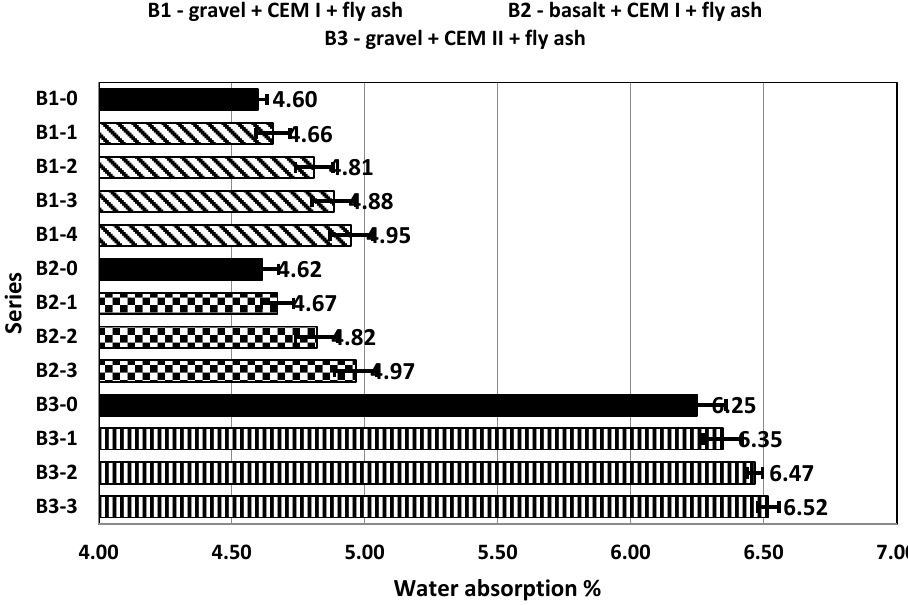
Figure 6. Water absorption of control concretes and concretes with the addition of fly ash.